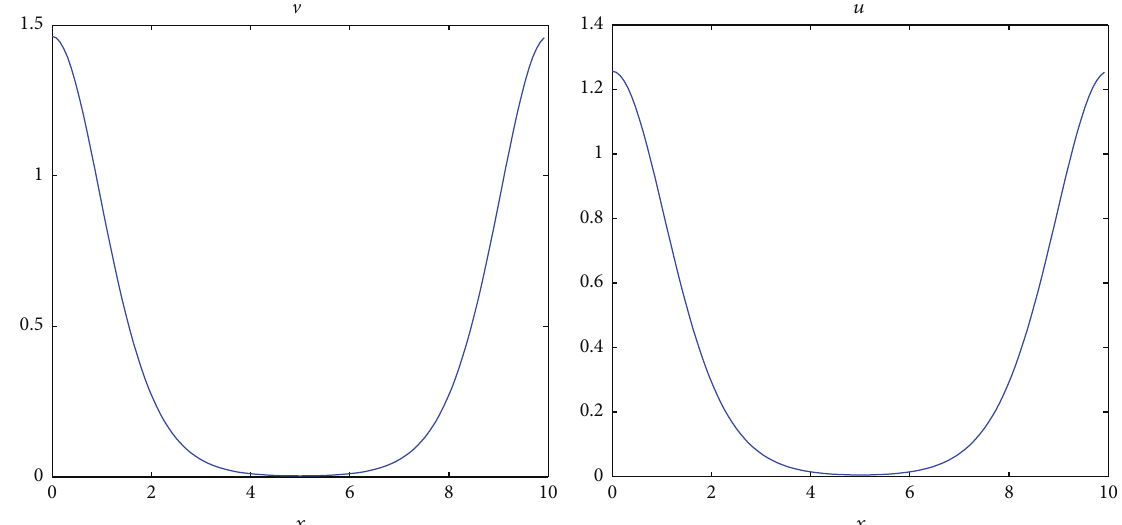
Figure 2: Periodic travelling wave solution of system (75) for 𝛼 = 𝛽 = 0.3 , 𝜎 = 0 , wave speed 𝑐 = 1.2 , and period 𝐿 = 10 , obtained after 7 Newton’s iterations.